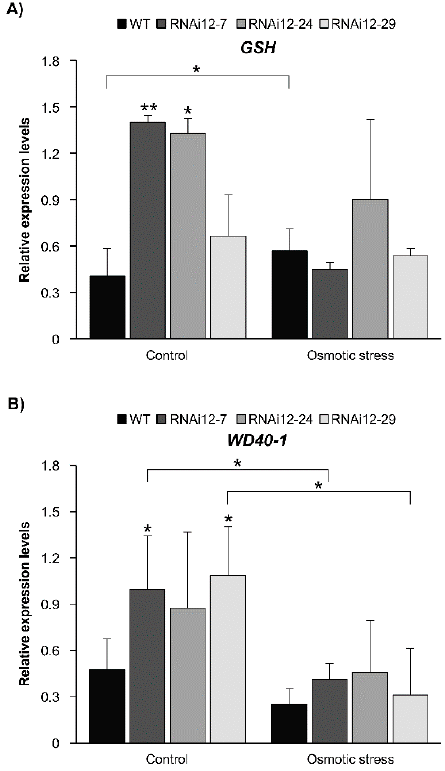
Figure 9. Relative transcript levels of stress-related genes in response to osmotic stress. Transcript levels of ( A ) GSH and ( B ) WD40-1 in WT and SPL12 -RNAi roots under osmotic (400 mM) and control conditions. * and ** indicate significant differences relative to WT using Student’s t -test (n = 3) p < 0.05, p < 0.01, respectively. Error bar indicates standard deviation.